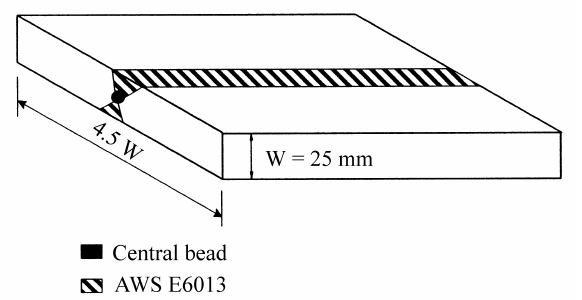
Figure 2. Jointconfigurationandpositionofthe twoelectrode